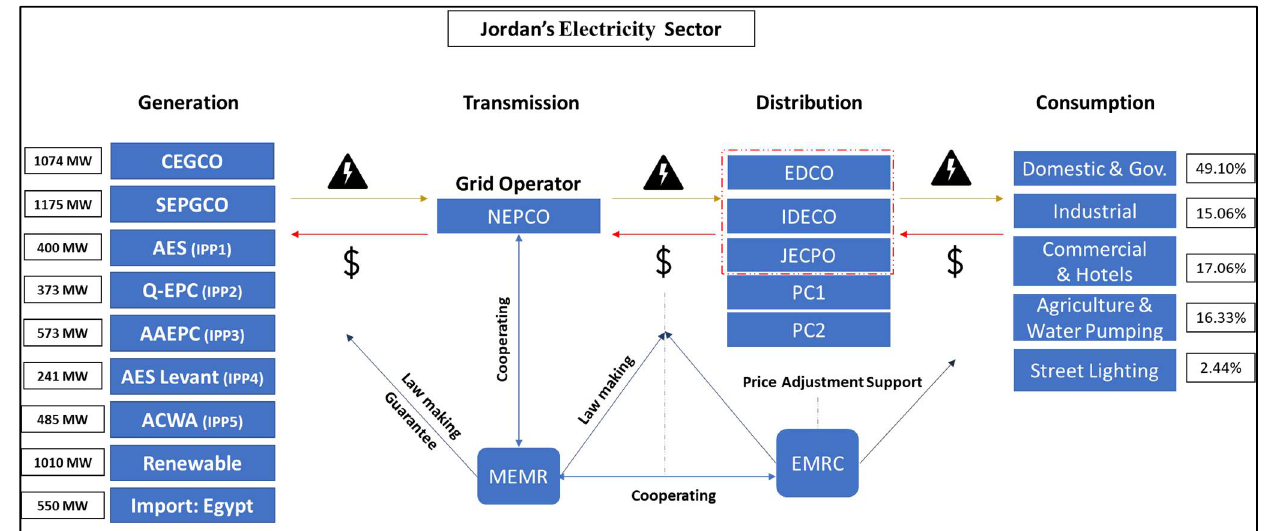
Figure 3. Jordan’s electrical sector—2019.